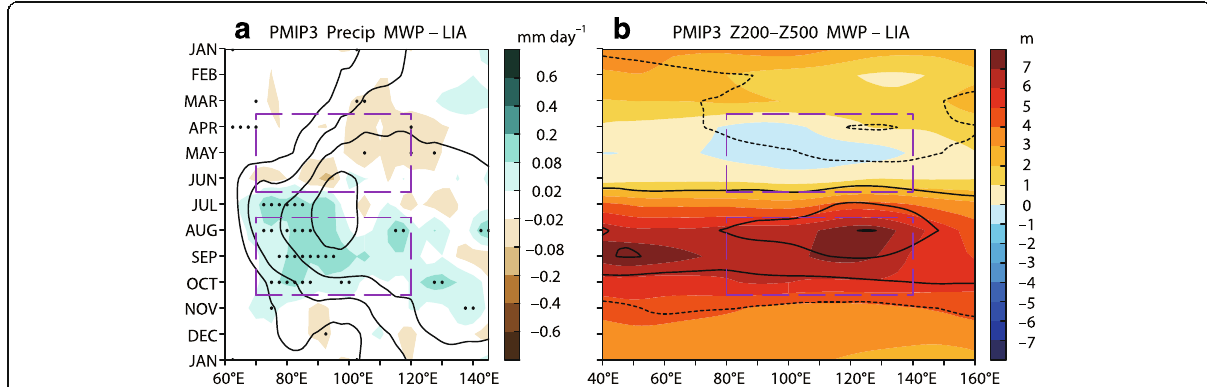
Fig. 4 Seasonal evolutions of ML anomalies in precipitation and tropospheric thickness. a Precipitation (mm day − 1 ) averaged over 15°N – 35°N. Contours represent climatology (1, 2, 4, 8 mm day − 1 ) during the LIA. Stipples indicate the areas with 95% statistical confidence. Dashed purple rectangles indicate the months and area examined in Table 3. b Thickness (m) between 200 and 500 hPa levels averaged over 25°N – 60°N. Contours represent the difference between 25°N – 60°N and EQ – 25°N ( − 6, − 4, − 2, 0, 2, 4, 6